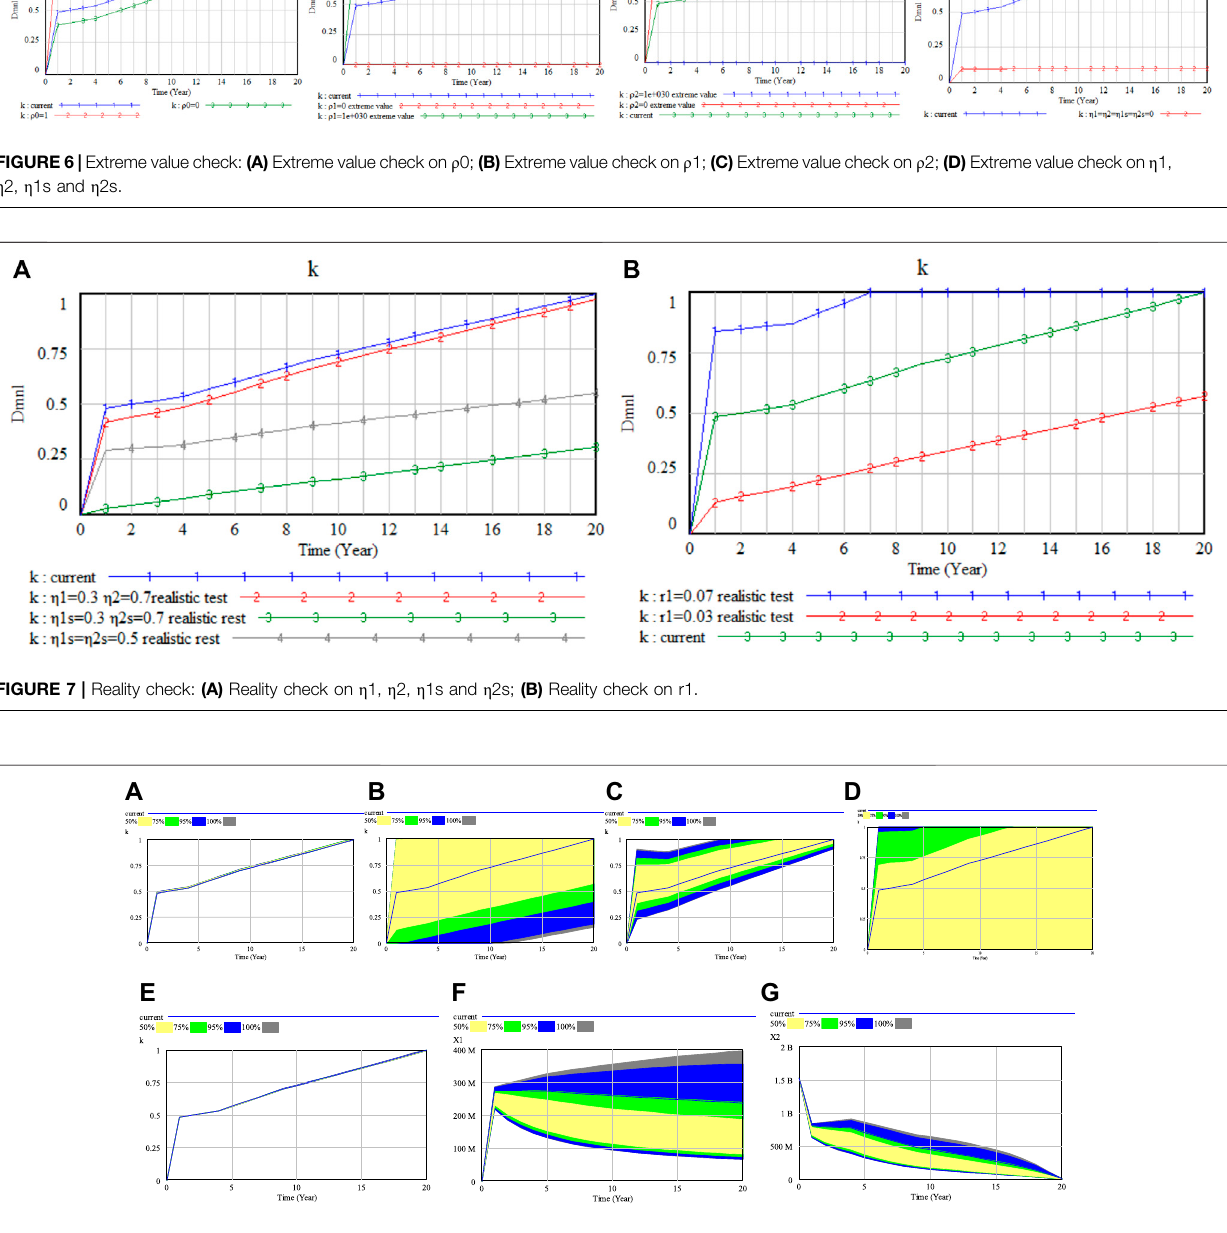
FIGURE 8 | Sensitivity test: (A) Sensitivity test on r; (B) Sensitivity test on r 1 ; (C) Sensitivity test on r 2 ; (D) Sensitivity test on α 2 ; (E – G) Sensitivity test on P g